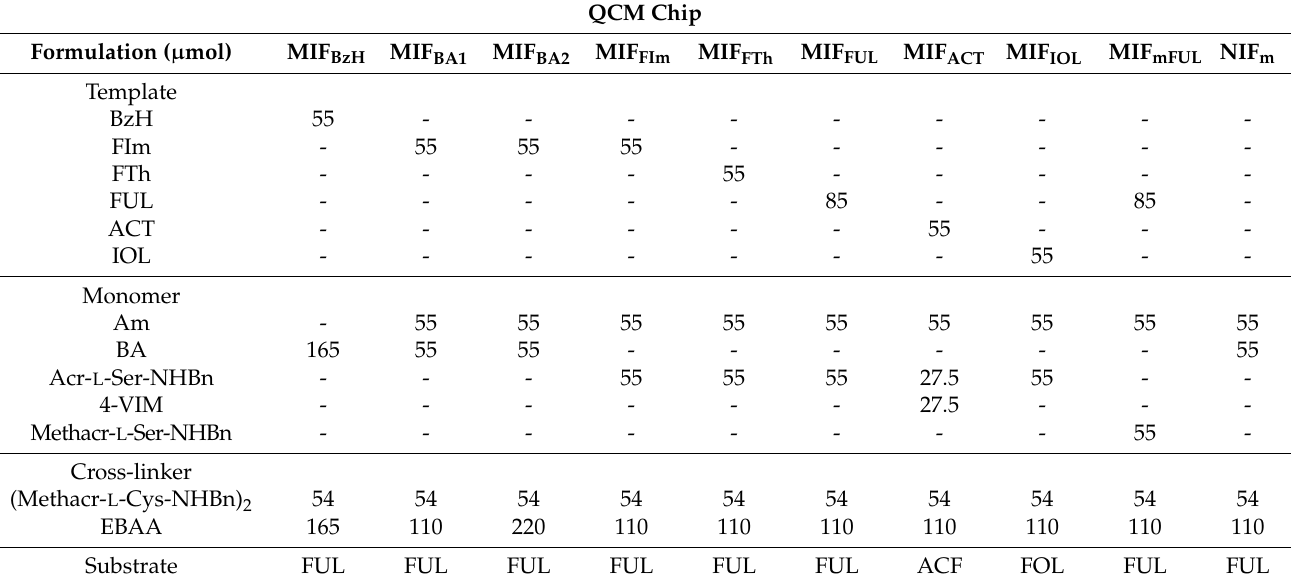
Table 1. Compositions of the monomer mixtures used for MIF